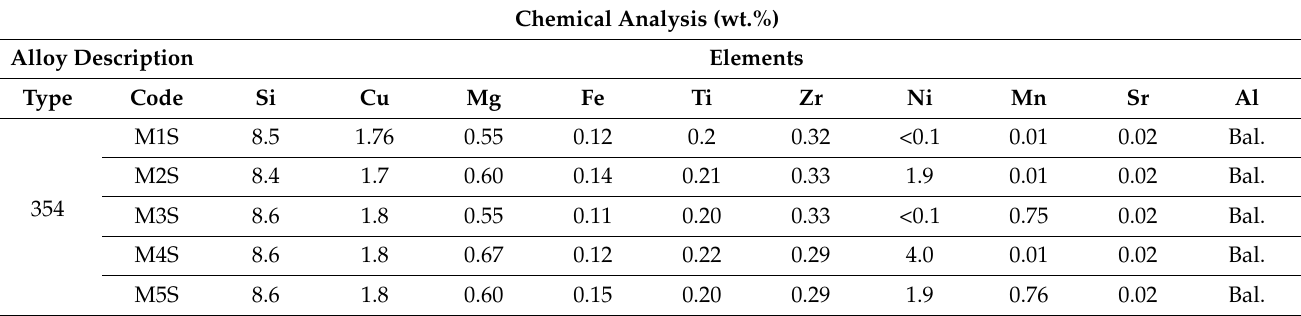
Table 1. Chemistry of the alloys studied.